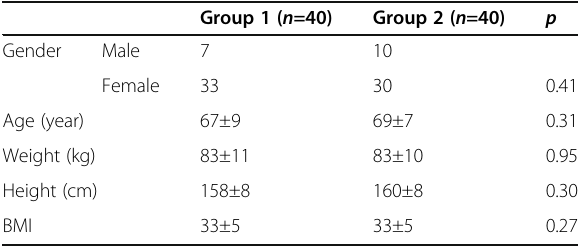
Table 1 Patient